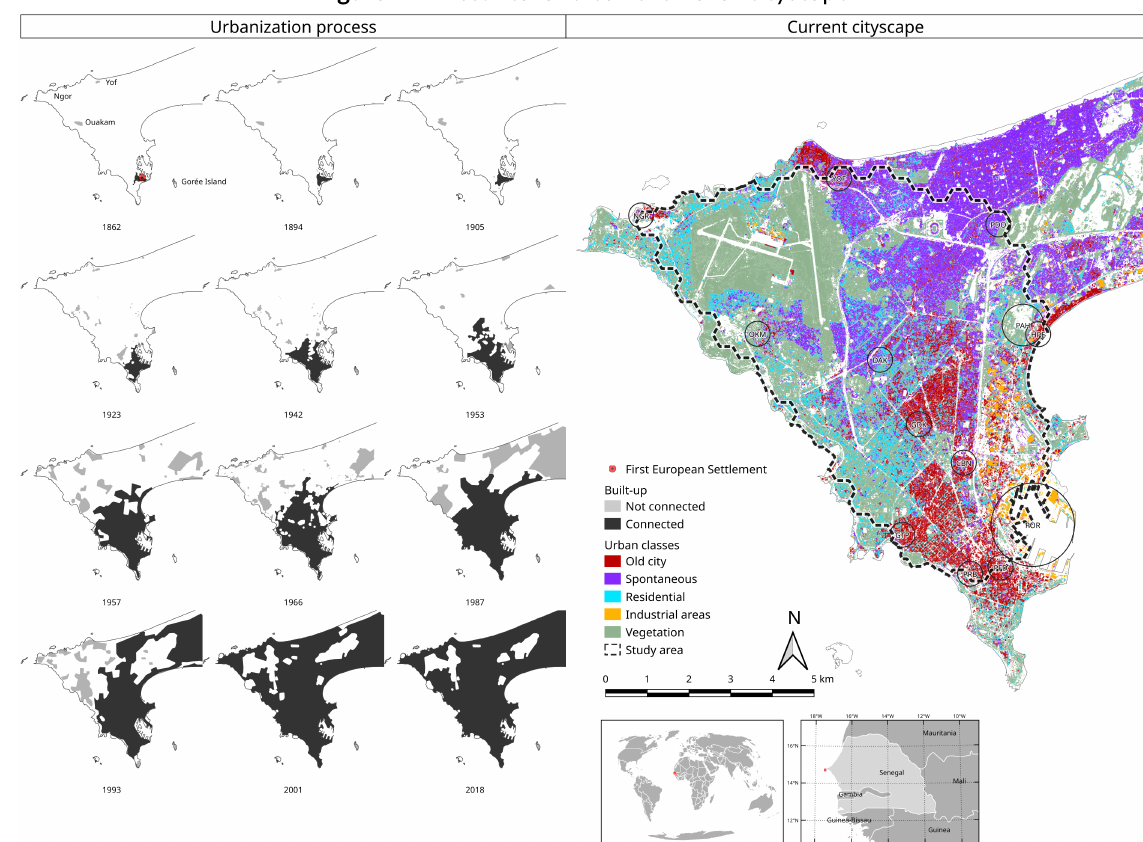
Figure 1 – Historical and current Dakar